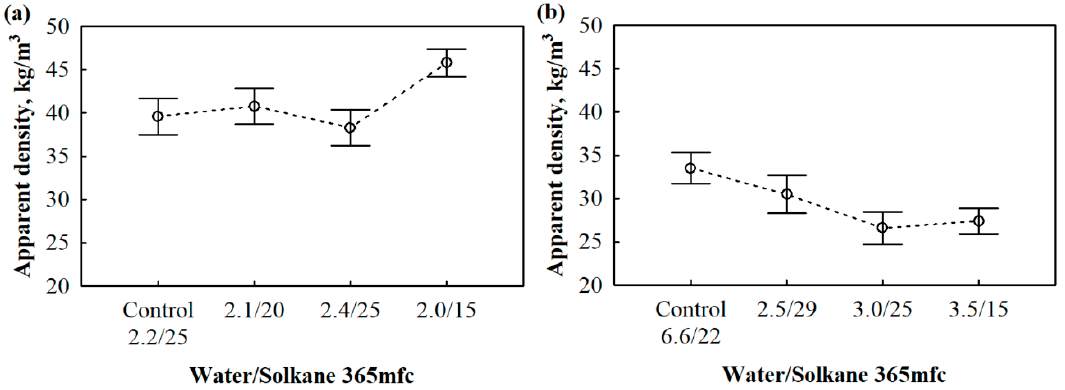
Figure 2. E ff ect of di ff erent rigid polyurethane foam compositions on apparent density variation: Figure 2. Effect of different rigid polyurethane foam compositions on apparent density variation: ( a ) ( a ) 40 kg / m 3 and ( b ) 30 kg / m 40 kg/m 3 and ( b ) 30 kg/m 3.